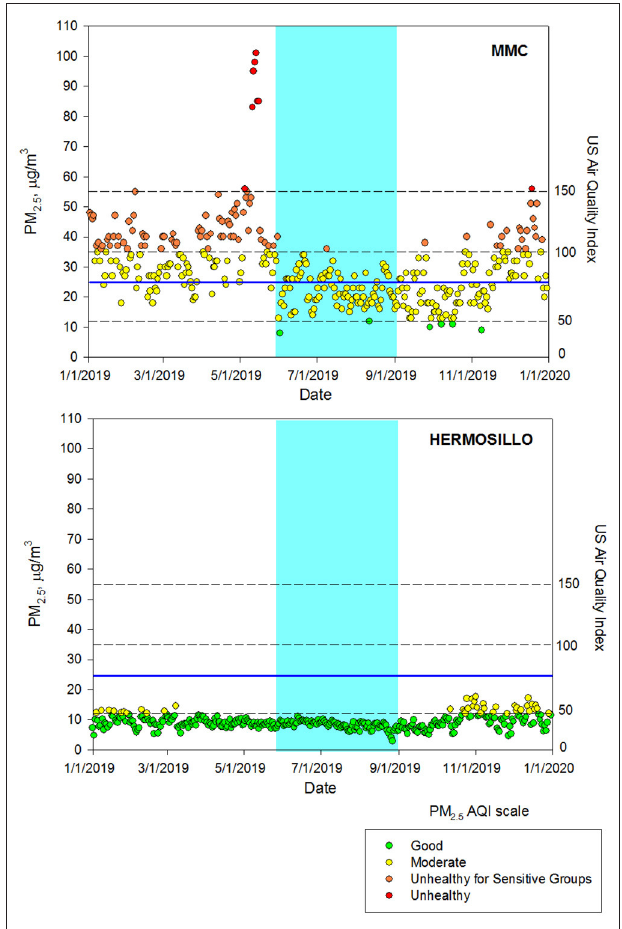
FIGURE 1 | Time-series of PM 2.5 24-h averages at MMC and Hermosillo from January 1, 2019 to May 31, 2020, classified according to the U.S. EPA AQI index*. *The blue continuous line depicts the 24-h average guideline of the WHO. The blue shade area represents the period during the MoCA evaluations. Air quality data are available from Sistema de Monitoreo Atmosferico del Gobierno de la Ciudad de México (http://www.aire.cdmx.gob. mx/default.php) and Red Universitaria de Observatorios Atmosféricos de la Universidad Nacional Autónoma de México (https://www.ruoa.unam.mx/).